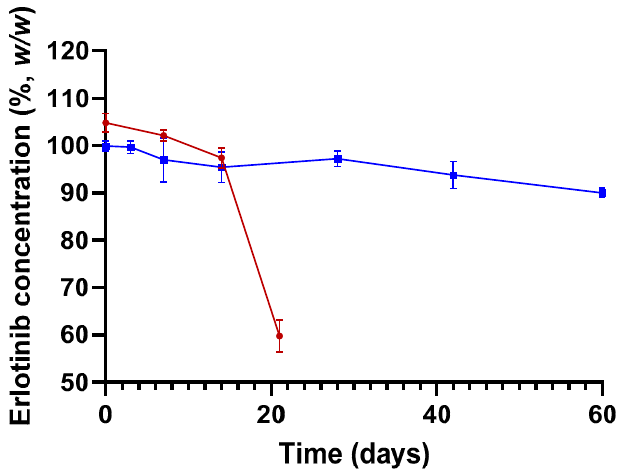
Figure 3. Stability of ERL 0.2% formulated in Nourivan Antiox ® at pH ~ 3.5 (red curve) and pH ~ 7.0 (blue curve). The lower (90%, w / w ) and upper (110%, w / w ) specifications are represented by the dotted grey horizontal lines. Each data point and associated standard deviation were obtained by analyzing the corresponding three batches of cream separately.